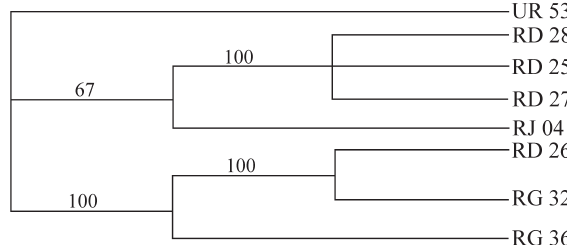
Figure 5 - Maximum parsimony tree of haplotypes of mtDNA sequences (cytb) of Hoplias malabaricus from the Rio Doce basin (RD25,RD26, RD27, and RD28), Rio Grande basin (RG32, RG36), and (Rio) Macuco river (RJ04). The outgroup is from a 2n = 40 H. malabaricus population from the (Rio) Uruguay river